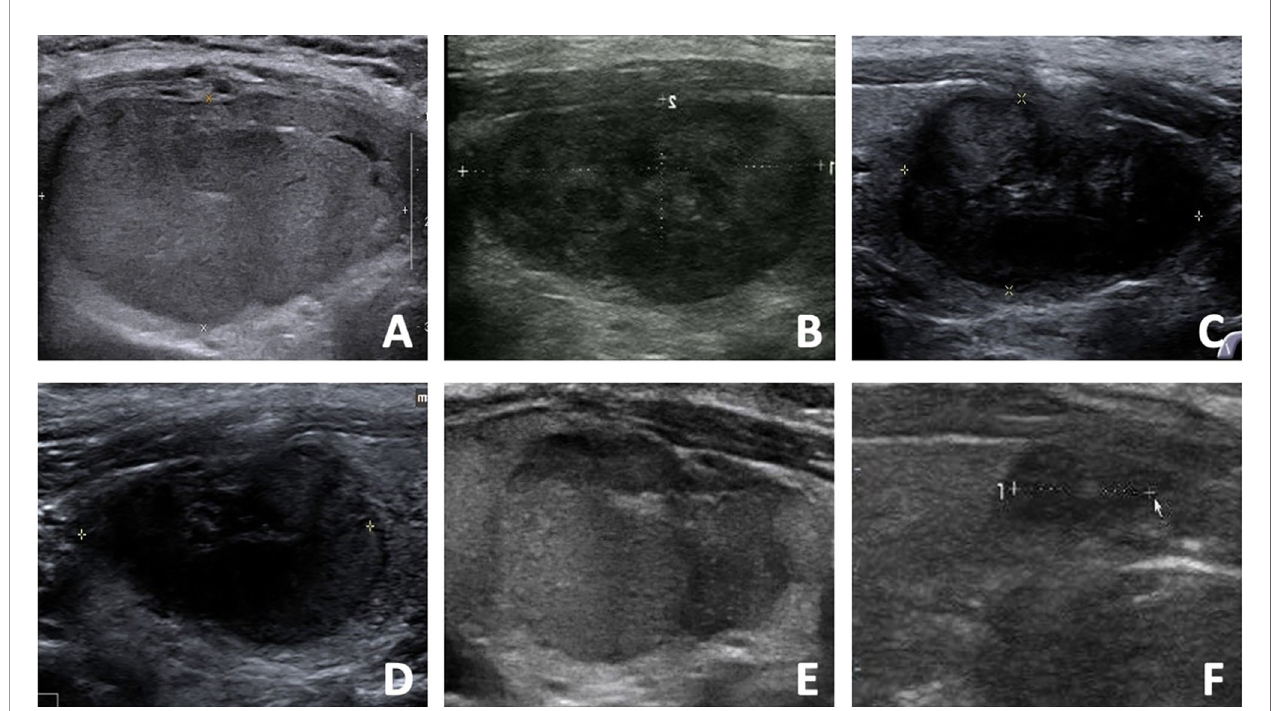
FIGURE 2 | The US images of a 48- year-old male with a benign thyroid nodule in the regrowth group. (A) The initial volume of nodule was 22.27 ml before RFA. The nodule was located in the dangerous location, and the vascularity was grade 4. The risk of regrowth by the nomogram was 67%. (B) At 1 month after RFA, the volume was 5.28 ml and VRR was 76.29%. (C) At 3 months after RFA, the volume was 3.48 ml and VRR was 84.37%. (D) At 6 months after RFA, the volume was 2.89 ml and VRR was 87.02%. (E) At 12 months after RFA, the US showed nodule regrowth and the volume was 4.34 ml and VRR was 80.51%. Additional RFA was performed. (F) At 6 months after additional RFA, the volume was 1.65 ml and VRR was